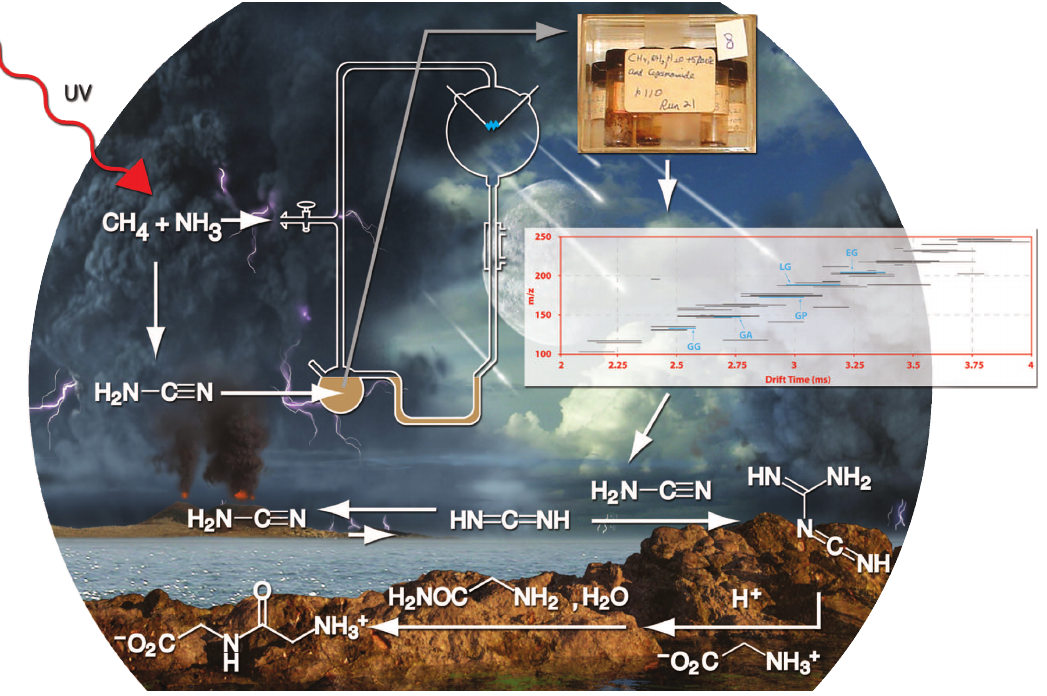
Figure 4. Schematic of the Miller-Urey apparatus, reproduced from the cover of Ref. [66]. Reprinted with permission from Wiley, Hoboken, NJ, USA,